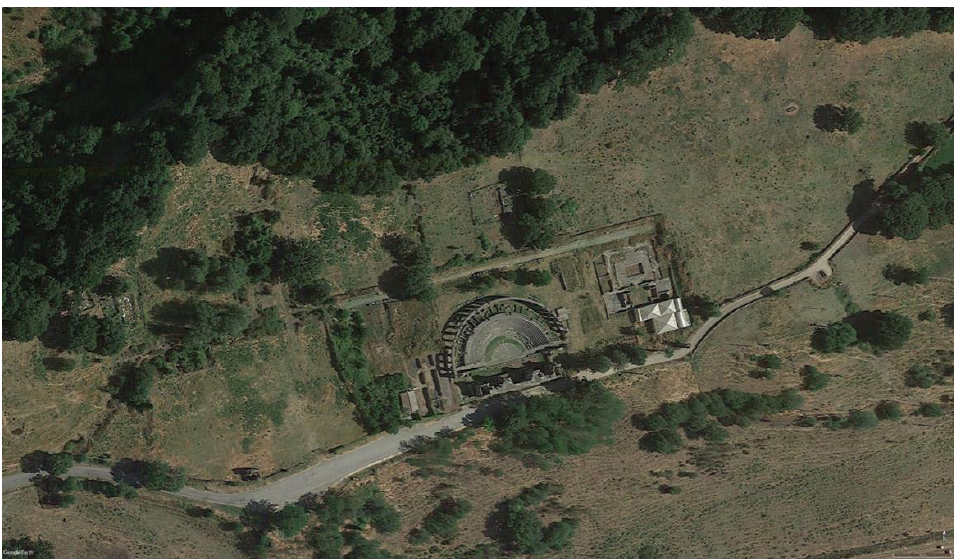
Figure 1. Aerial view of the archaeological site of Ferento with the Roman theater well-visible in the center of the image.